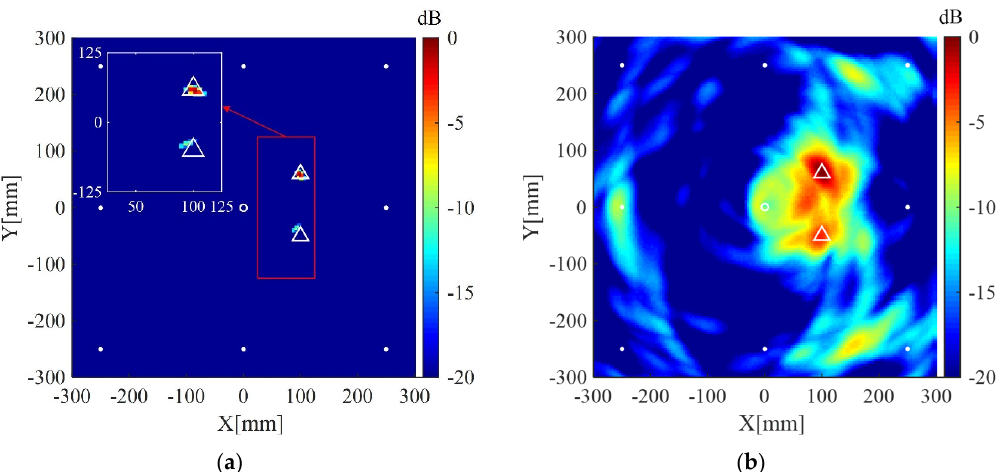
Figure 9. ( a ) Imaging result of the weighted structured sparse reconstruction ‐ based Lamb wave imaging method using data from eight receivers for two scatterers (the location error is 3 mm for defect #1, and 8 mm for defect #2); ( b ) Imaging result of the delay ‐ and ‐ sum imaging method using data from eight receivers for two scatterers (the location error is 3 mm for defect #1, and 8 mm for defect #2). White dots denote locations of PZT receivers, the white circle denotes the location of excitation source, and the white triangles denote the locations of the scatterers.